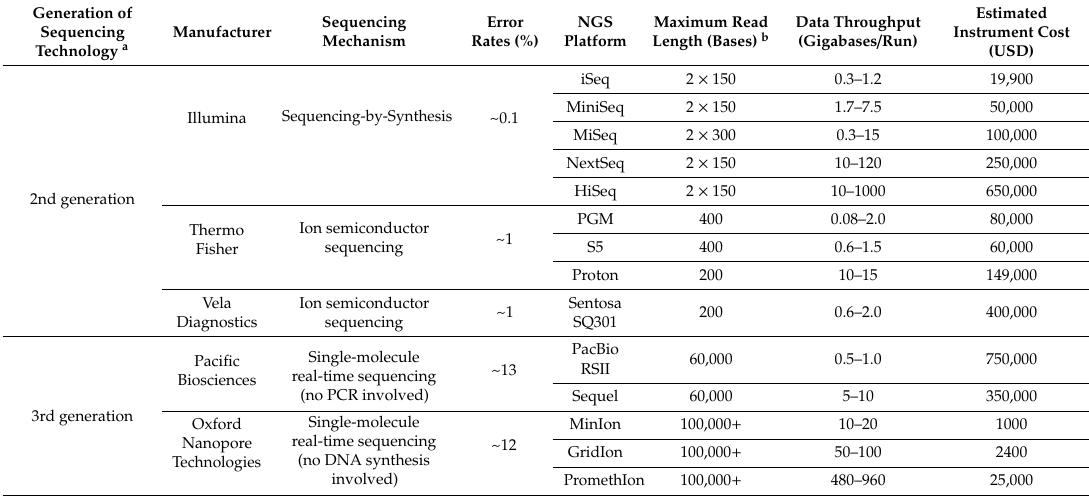
Table 1. Currently available next-generation sequencing (NGS) sequencing